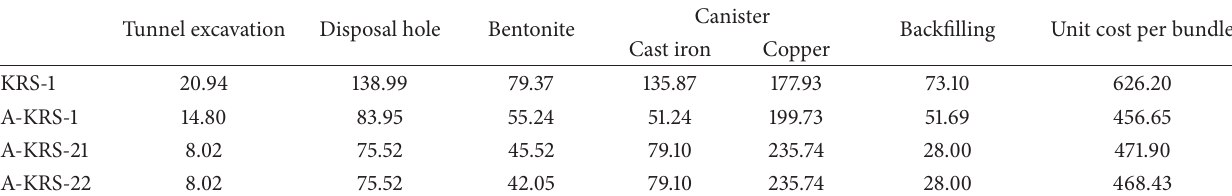
Table 4: The cost analysis results of four disposal alternatives (unit: USD/bundle).